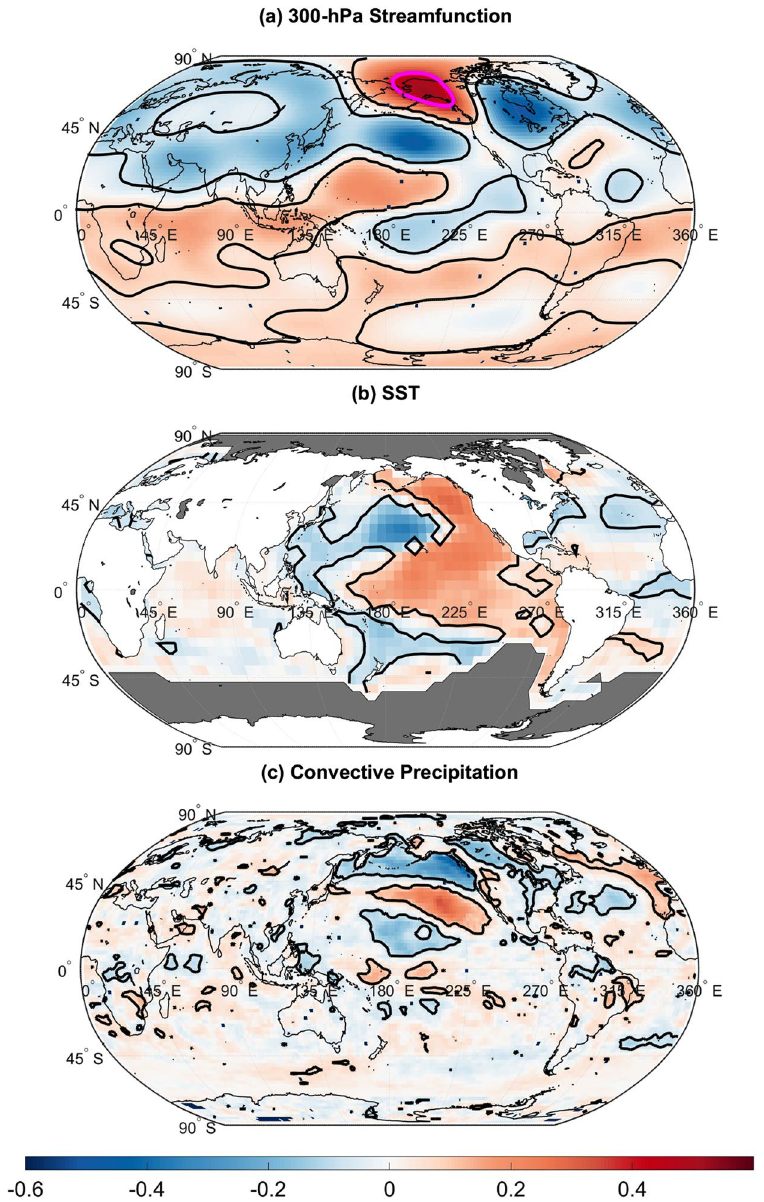
Figure 4. Correlation between EP/NP index and Atmospheric fields. ( a ) Correlation between EP/NP index and 300-hPa streamfunction. Black contours enclose regions of 5% statistically significance and the magenta contour encloses a region containing correlation coefficients greater than 0.4 used to fill the missing EP/NP index data. ( b ) Same as ( a ) but for SST. ( c ) Same as ( a ) but for convective precipitation. The map was generated using MATLAB’s geoshow routine (MATLAB 2015a,